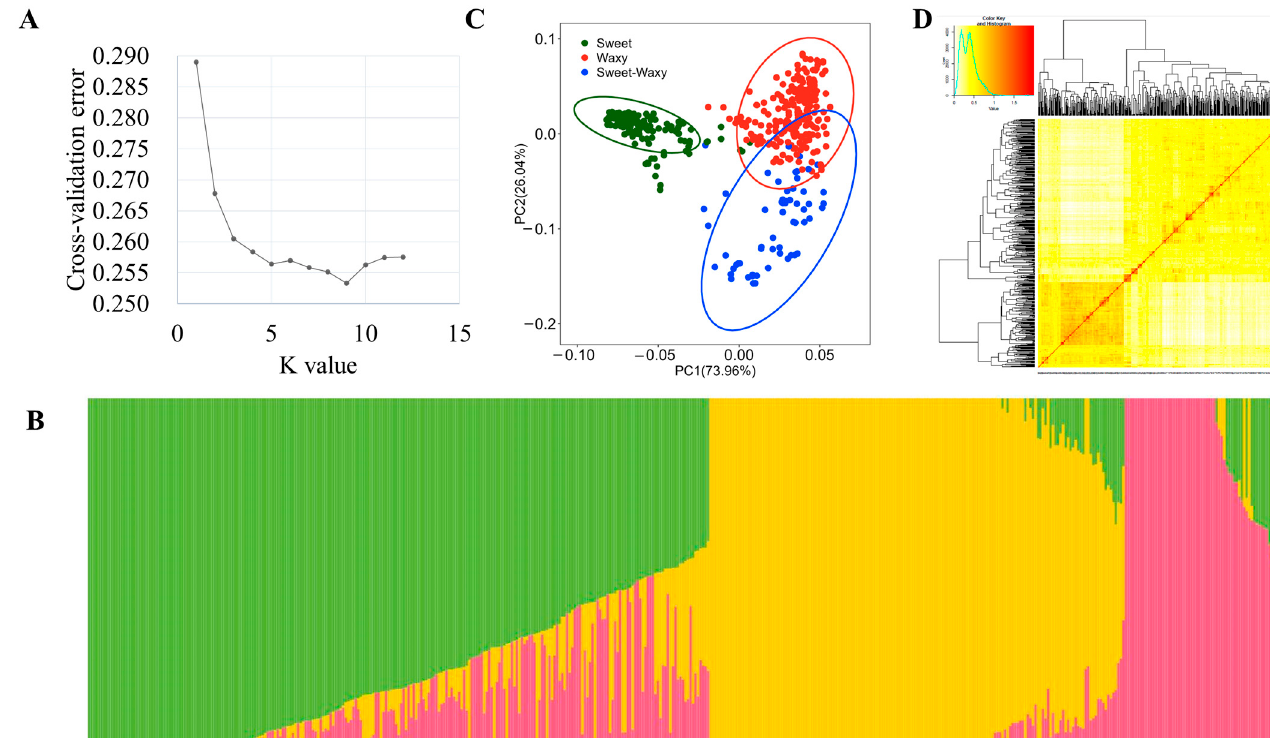
Figure 5. Analysis of genetic diversity. ( A ) ∆ K-value of 477 inbred lines. ( B ) The Bayes cluster plot of 477 maize inbred lines when K = 3. ( C ) Principal component analysis. ( D ) Distribution of pairwise relative kinship for 477 maize inbred lines calculated.